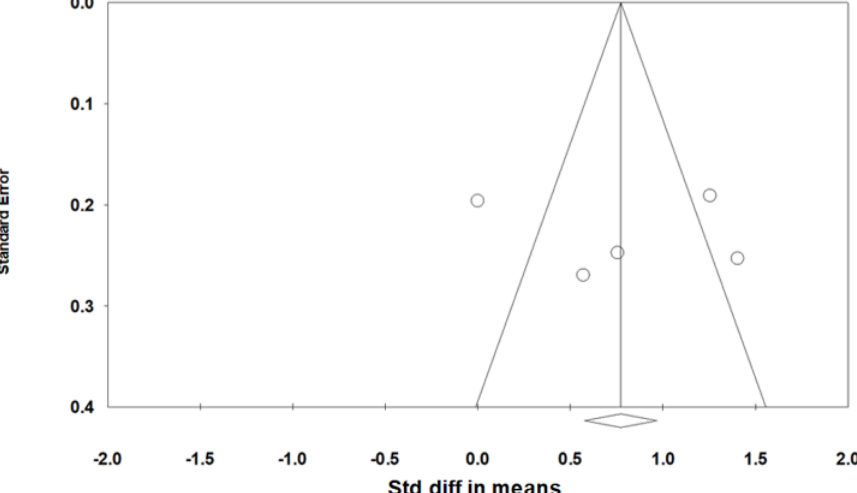
Figure 5. Funnel plot for the effects of pharyngeal obstructive sleep apnea surgery on positive airway pressure usage time. There was no publication bias (the Egger test p -value = 0.792). Std diff, standardized difference.